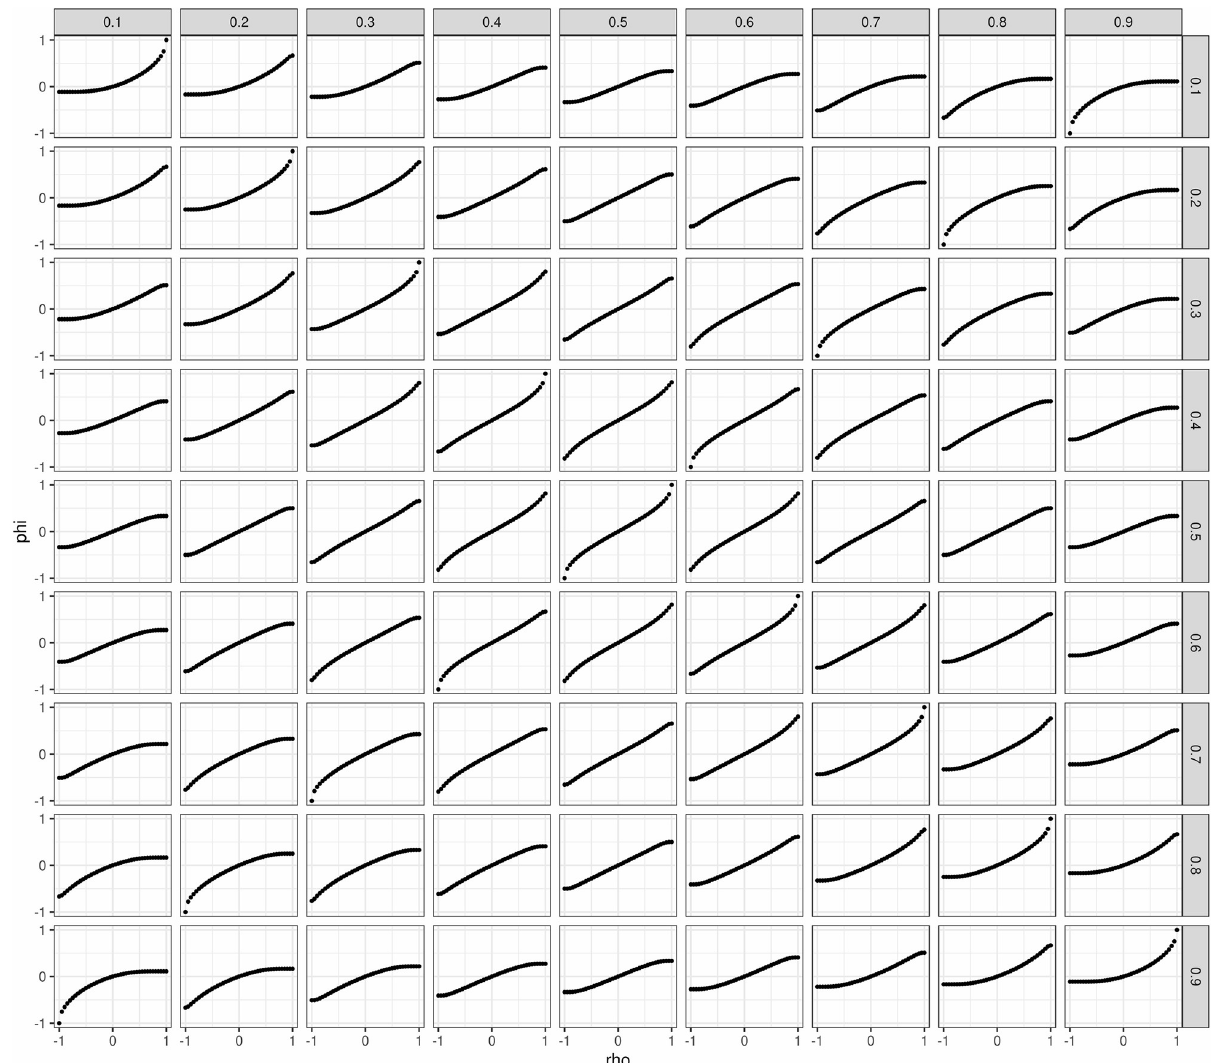
Fig 10. Relationship between specified correlation of the two continuous endpoints ρ k prior to dichotomization and achieved correlation ϕ k of the two binary endpoints after dichotomization. Only when p k lower bound of ϕ k is to 0. Please note that in the Figure the labels “phi” and “rho” are used for ϕ and ρ .